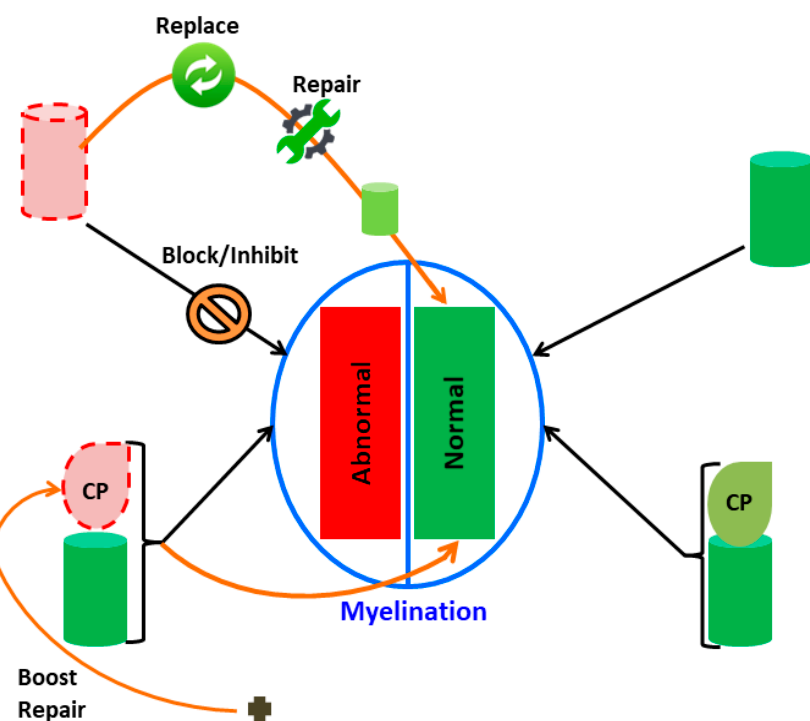
Figure 2. Possible pathways to investigate the mechanisms of myelination defects involving chaperones and pertinent chaperonotherapy strategies. Normal and abnormal myelination (green and red rectangles, respectively) are shown within the central oval. Chaperones (cylinders) normal (green) or abnormal (pink with red-dashed borders); pertinent client proteins (CP; drop-shaped icons) may be normal (green) or abnormal (pink with red-dashed borders). The normal mechanism of myelination is represented on the right, while mechanisms involved in abnormal myelination are schematized on the left side of the figure; there are here two possibilities: chaperone failure (top) or client polypeptide (CP) defect (bottom). Chaperone failure is amenable to positive chaperonotherapy consisting of chaperone replacement (gene or protein, or artificial chaperone) or chaperone repair (by means of chaperone-activating compounds). Also shown is the case of a chaperone interfering with the normal process of myelination, that is, chaperonopathy by mistake, which is amenable to negative chaperonotherapy, consisting of blocking/inhibiting the pathogenic chaperone, as shown by the descending black arrow crossed with a forbidden sign. If the client protein is defective (proteinopathy; bottom), it is possible to boost it with chemical chaperones (black cross at the bottom) and reconstitute its function, at least partially.